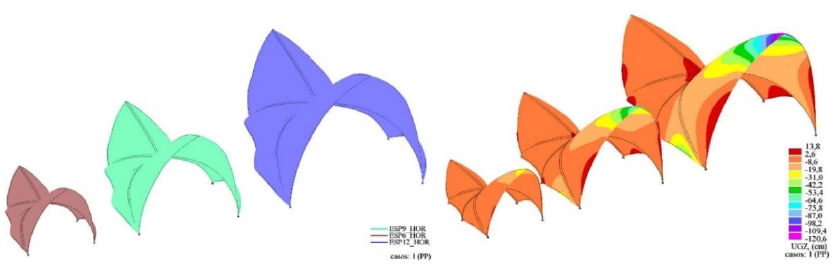
Figure 17. Left : full-scale calculation model (blue), scaled 75% (green) and scaled 50% (red). Right : displacements of the nodes of the structure in the global Z -axis for the self-weight load